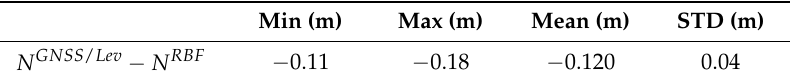
Table 4. The statistics of the geoidal height test at the GNSS/levelling points.